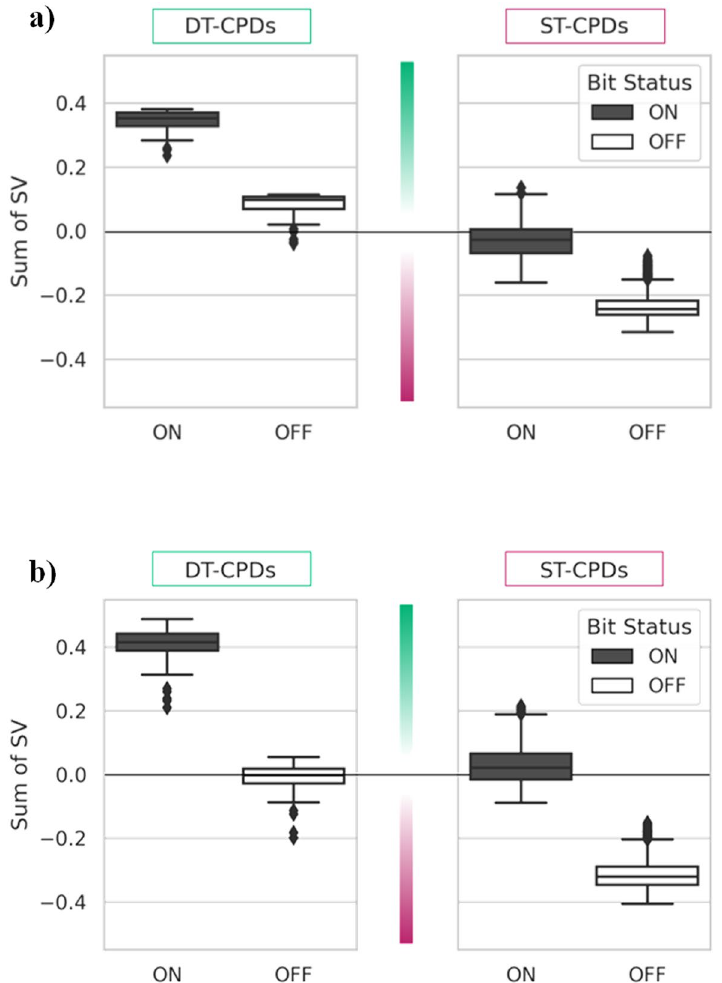
Figure 2. Global contributions of present and absent features. For each correctly classified DT- and ST-CPD, the sum of SVs was calculated separately for representation features that were present (bit status on, black) or absent (off, white). ( a ) Shows results for the MAOB-A2aR and ( b ) for the MAOB-AChE target pair. SV distributions are captured as box plots. The upper and lower whiskers indicate maximum and minimum values, the boundaries of the box represent the upper and lower quartiles, and the median is depicted as a horizontal